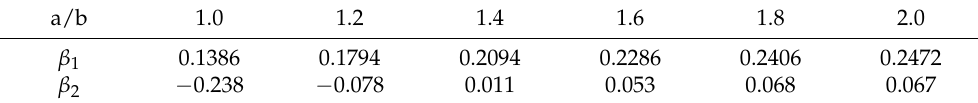
Table 1. Coefficients when rectangular flat-plate functioned by uniform load [16].